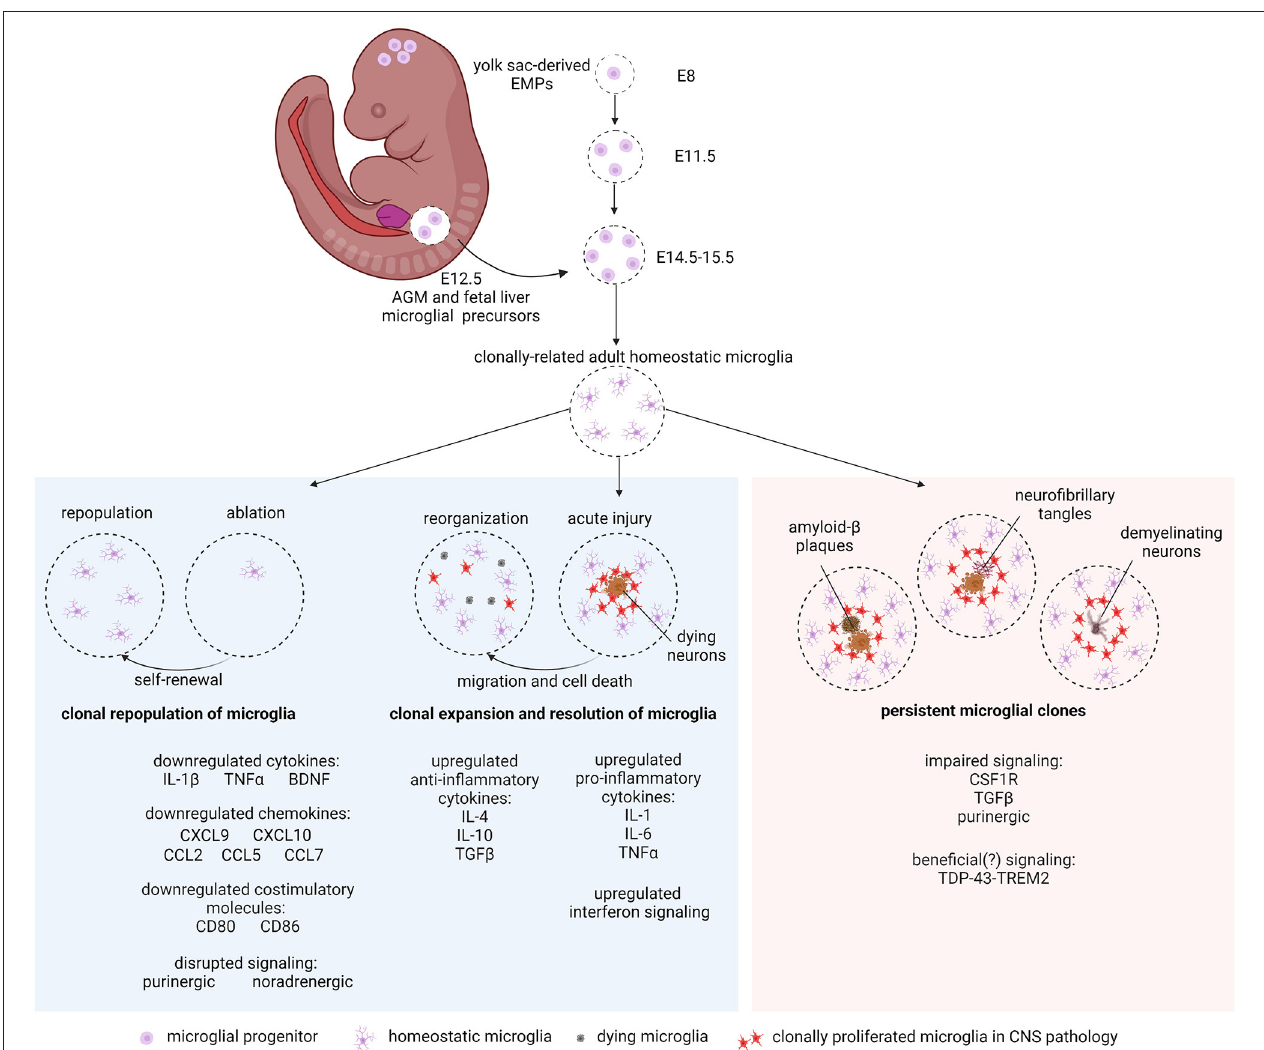
FIGURE 1 | Microglial clonality in development, health, and disease. Yolk sac EMPs enter the mouse neuroepithelium from E8 to E11.5 where they clonally expand and colonize the brain niche. An additional influx of Hoxb8 + microglial precursors from the AGM and fetal liver at E12.5 invade and populate the brain between E14.5 and E15.5 to make up the rest of the postnatal resident microglial population. Microglia clonally repopulate after ablation via self-renewal (left panel). In acute injury, microglia respond by microgliosis (clonal proliferation) at the site of damage (center panel). With clinical recovery, clones of microglia are reorganized by microglial cell migration and cell death (center panel). In chronic neurodegeneration such as AD, PD and MS, microglial clones persist around A β plaques, neurofibrillary tangles (tauopathy), and demyelinating neurons (right panel). Altered gene regulation and signaling pathways mentioned in the text are indicated. Created with